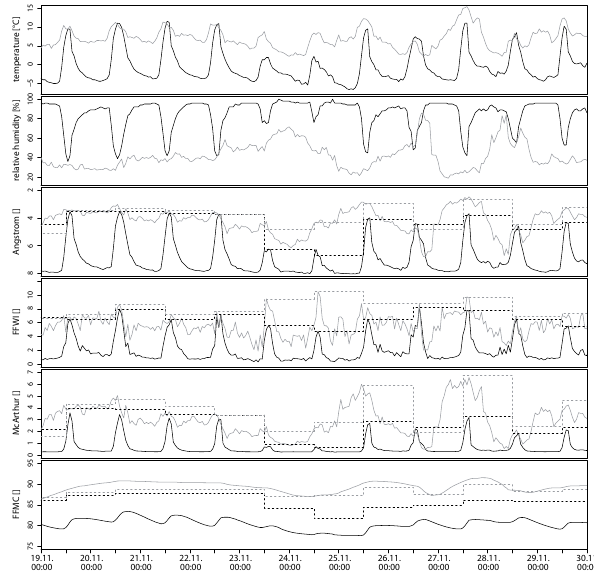
Fig. 8. Meteorological conditions and selected fire danger indices (solid lines: hourly values, dashed lines: daily values) at Garmisch- Partenkirchen (black lines) and Felsenkanzel (grey lines) stations. Note that for the Angstrom index, the y axis has been inverted since high values represent low fire danger and low values represent high fire danger, in contrast to all other indices. For fire occurrence in- formation, refer to Sect.